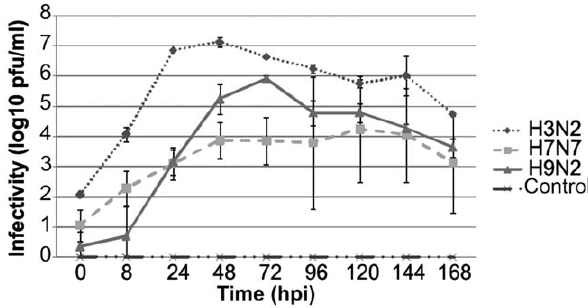
Figure 5. Infection of PCLS by porcine and avian influenza viruses evaluated by titration of infectious virus. PCLS were mock-infected or infected by porcine H3N2, avian H9N2, or avian H7N7 virus. Up to 7 days post infection, infectious virus released into the